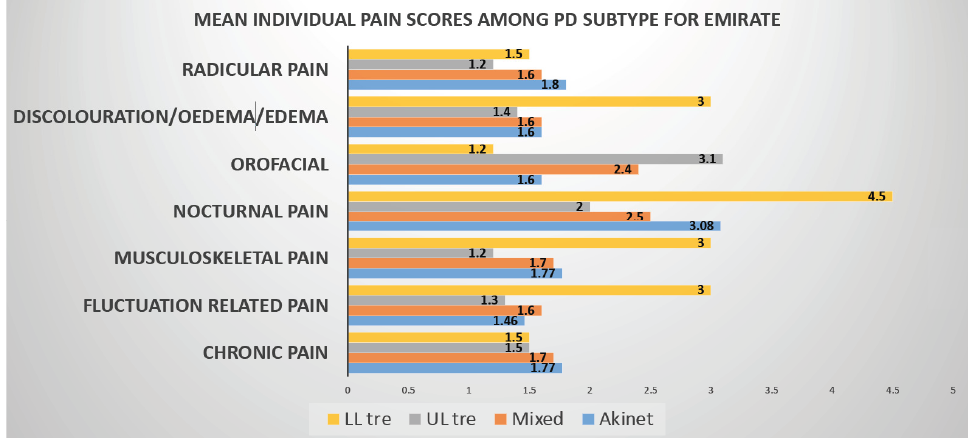
Figure 1. Graphical representation of PD subtype vs. pain domains (KPPS) in Emiratis. In this graph it can be seen that Nocturnal pain (NP) is found to be higher in all the PD Subtypes where as Radicular pain scores high in Tremor Dominant Subtype.